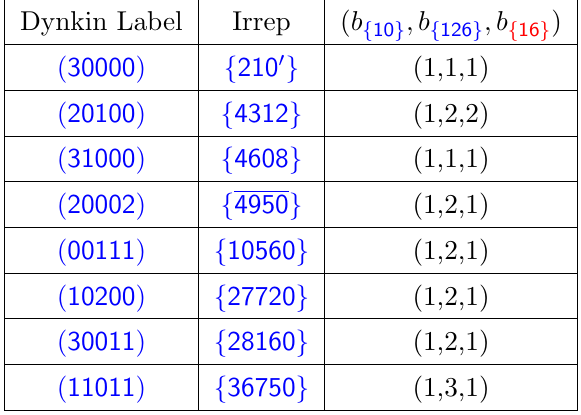
Table 9 . Summary of bosonic super(cid:12)elds that contain gauge 1-form(s) and 5-form(s) at level-8, and gaugino(s) at level-9